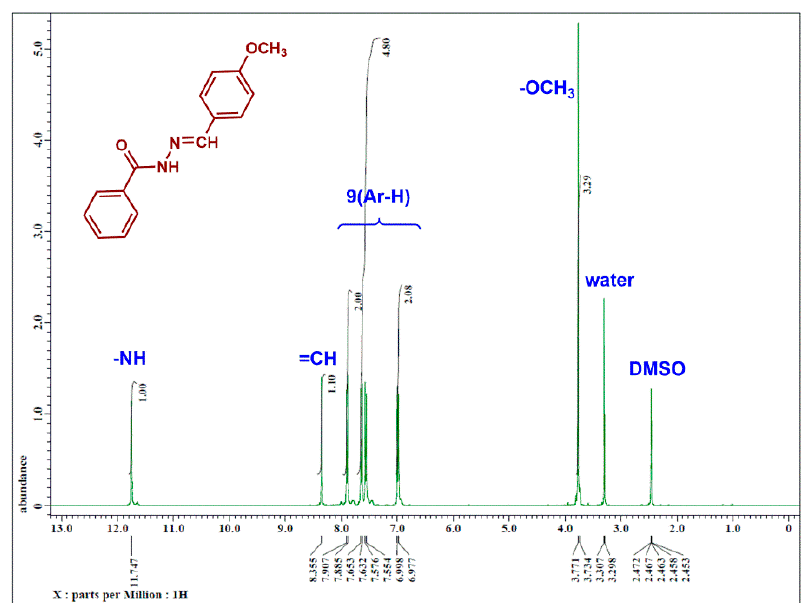
Figure 2. Fourier transform infrared spectra of the N ′ -(4-methoxybenzylidene)benzohydrazide (HL) ligand and its nickel(II) complex (Ni(II)-2L).